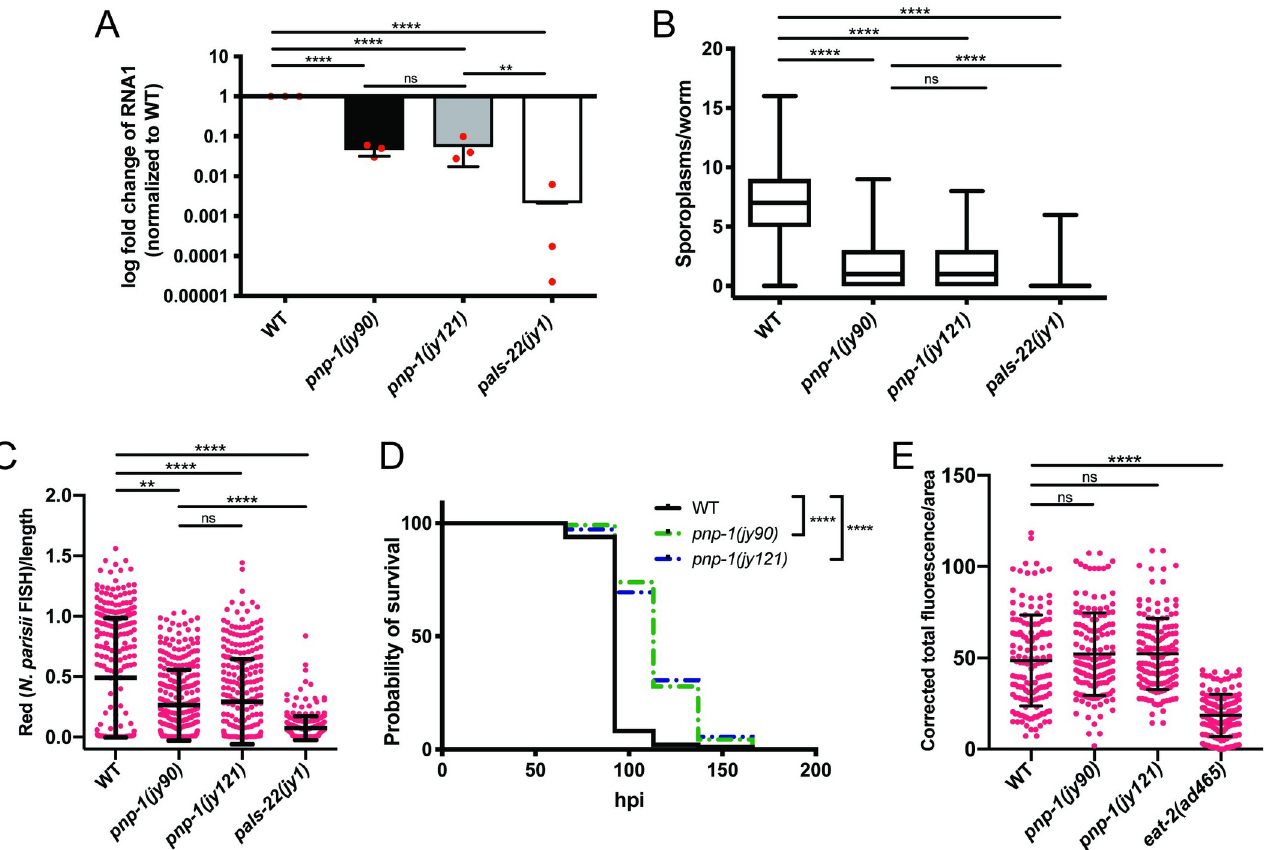
Fig 2. pnp-1 regulates intracellular pathogen resistance. A) qRT-PCR for Orsay viral load in wild-type animals, pnp-1(jy90) , pnp-1(jy121) and pals-22(jy1) mutants. Fold change in gene expression is shown relative to wild-type animals. Graph shows results of three independent experiments. Mean is shown with error bars as SD. Red dots indicate values from individual experiments. Synchronized fourth larval stage (L4) animals were used. ���� indicates p < 0.0001 by a one-tailed t-test. B) Quantification of N . parisii sporoplasm number in wild-type animals, pnp-1(jy90) , pnp-1(jy121) and pals-22(jy1) first larval stage (L1) mutants at 3 hpi. n = 225 animals per genotype. Box represents 50% of the data closest to the median while whiskers span the values outside the box. C) Quantification of N . parisii pathogen load in wild-type animals, pnp-1(jy90) , pnp-1(jy121) and pals-22(jy1) L1 mutants at 30 hpi. n = 300 animals per genotype. N . parisii load per animal was quantified with the COPAS Biosort machine and normalized to time-of-flight as proxy for the length of the animal. Each dot represents an individual animal. Mean is shown with error bars as SD. B, C) N . parisii was visualized using an N . parisii rRNA specific probe. Each graph shows the combined results of three independent experiments. D) Survival of wild-type, pnp-1(jy90) and pnp-1(jy121) mutants after infection with N . parisii . n = 120 per genotype. One experiment of three independent experiments is shown (see S4 Fig for additional two experiments). ���� indicates p < 0.0001 by the Log-rank (Mantel-Cox) test. E) Quantification of fluorescent bead accumulation in wild-type animals, pnp-1(jy90) , pnp-1(jy121) and eat-2(ad465) mutants. n = 150 animals per genotype. The corrected total fluorescence per worm was calculated and normalized to worm area. Each dot represents an individual animal. B, C and E) ���� indicates p < 0.0001 by the Kruskal-Wallis test. Graphs show combined results of three independent experiments.